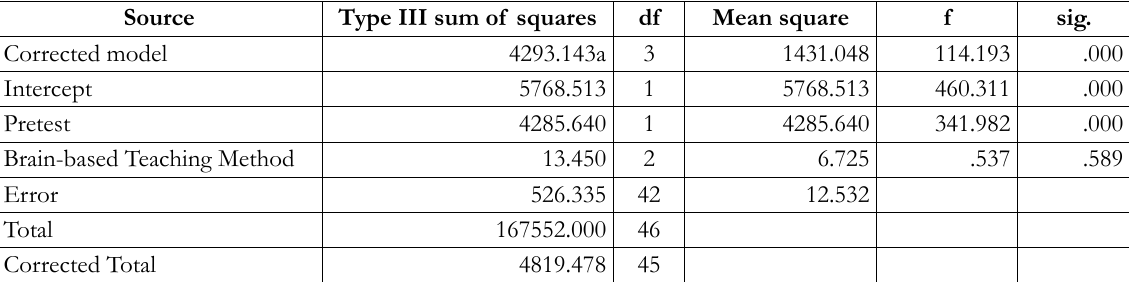
Table 7. Influence of Self-efficacy on Students